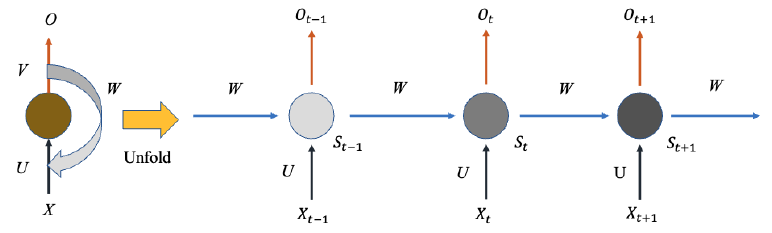
Figure 6. The structure of